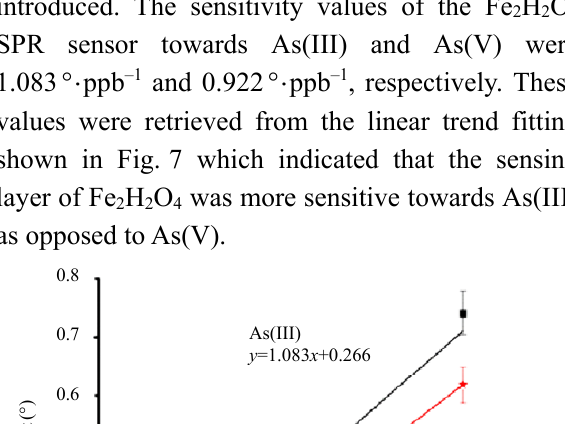
Table 1 SPR-based sensors for the detection of